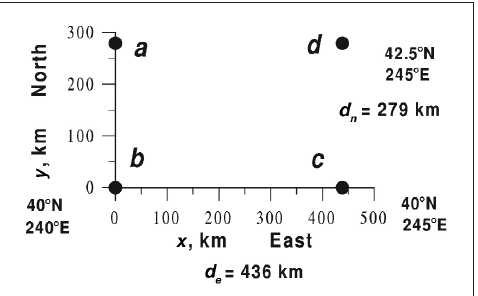
Fig. 2. Geometry of an elementary GIM cell. Nodes of the cell are denoted a , b , c and d . The cell size is determined by the values of d n = 279 km and of d e dependent on the cell’s location